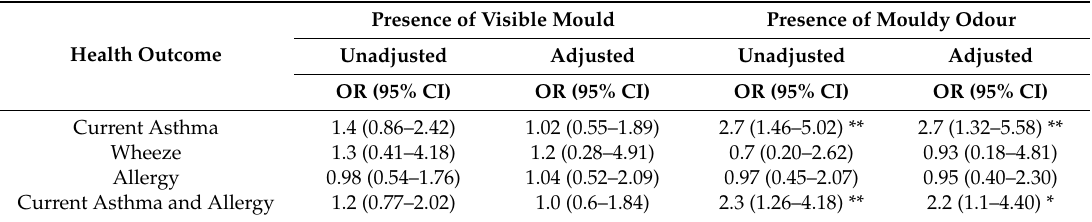
Table 3. Association between indoor mould contamination and risk of adult asthma, wheeze and allergy.